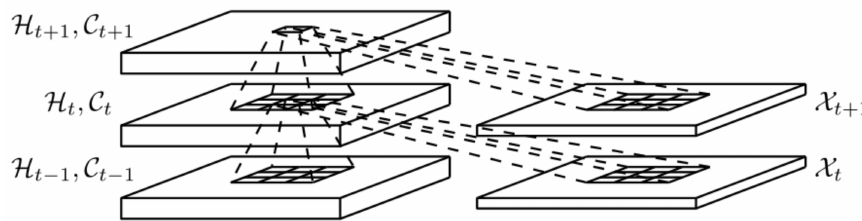
Figure 3. The inner structure of